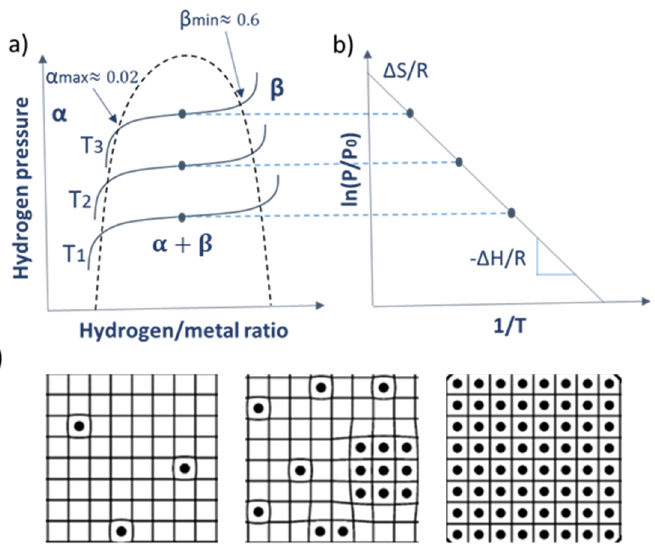
Figure 2. ( a ) Pressure − Composition-Temperature (PCT; where T 1 < T 2 < T 3 ) isotherms of the ideal Pd-H system including the regions corresponding to the three phases ( α , β , and α + β ) of the system, and the temperature-dependent plateau that disappears at high temperatures. ( b ) Van’t Hoff diagram corresponding to the isotherms of Figure 1a. ( c ) Illustrations showing the fraction of H atoms (black dots) in the Pd interstitial sites for the different phases: α phase (left), α + β phase (middle), and β phase (right).